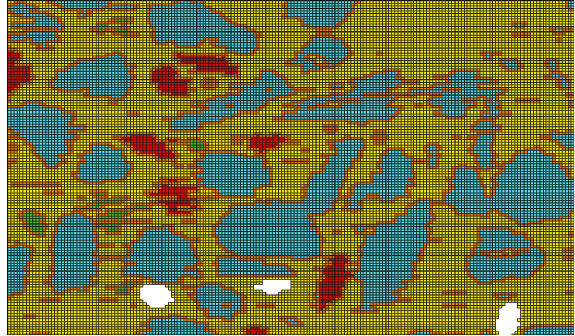
Figure 12: Reconstruction partial